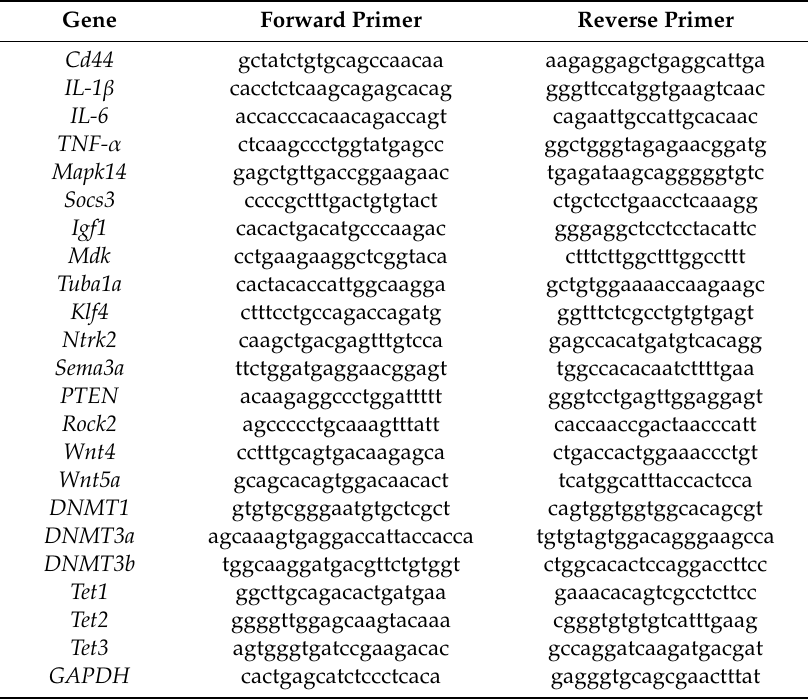
Table 1. Primer sequences used for real-time PCR gene expression